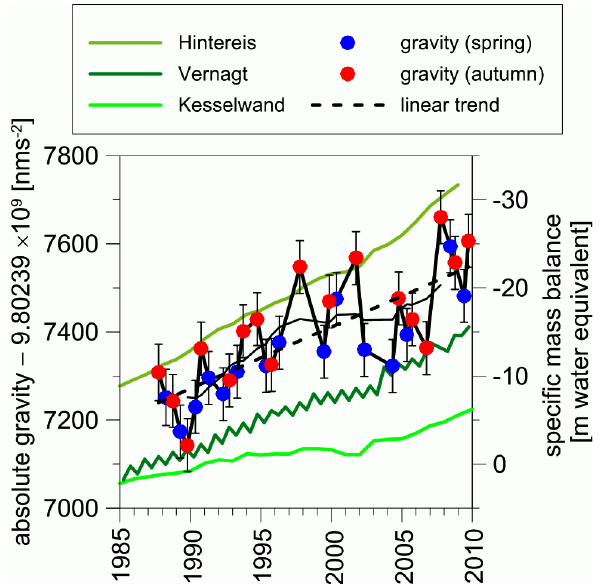
Fig. 2. Absolute gravity time series at Obergurgl (weighted means of each campaign) between 1987 and 2009. Symbols in blue refer to observations in spring; red symbols are used for autumn campaigns. A significant gravity increase can be derived for this time period. Gravity values determined in autumn tend to be greater than values determined in spring. Gravity is compared with cumulative specific mass balance observations (greenish colors) for prominent glaciers within the ¨Otztal Alps (Austria) (Kuhn et al., 1999; Fischer and Markl, 2009; WGMS,